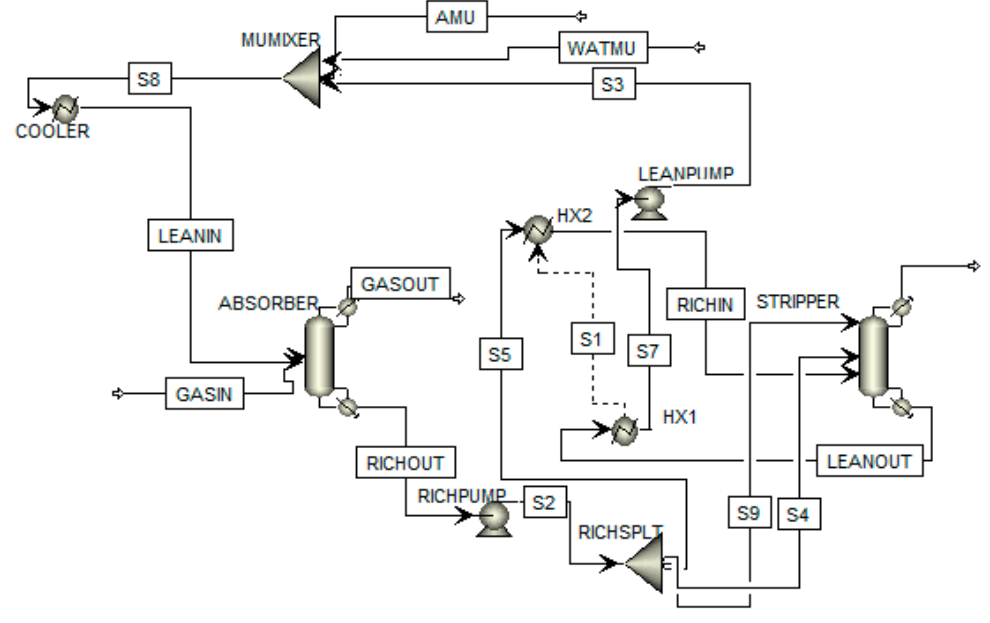
Figure 3. Rich split modification [11].